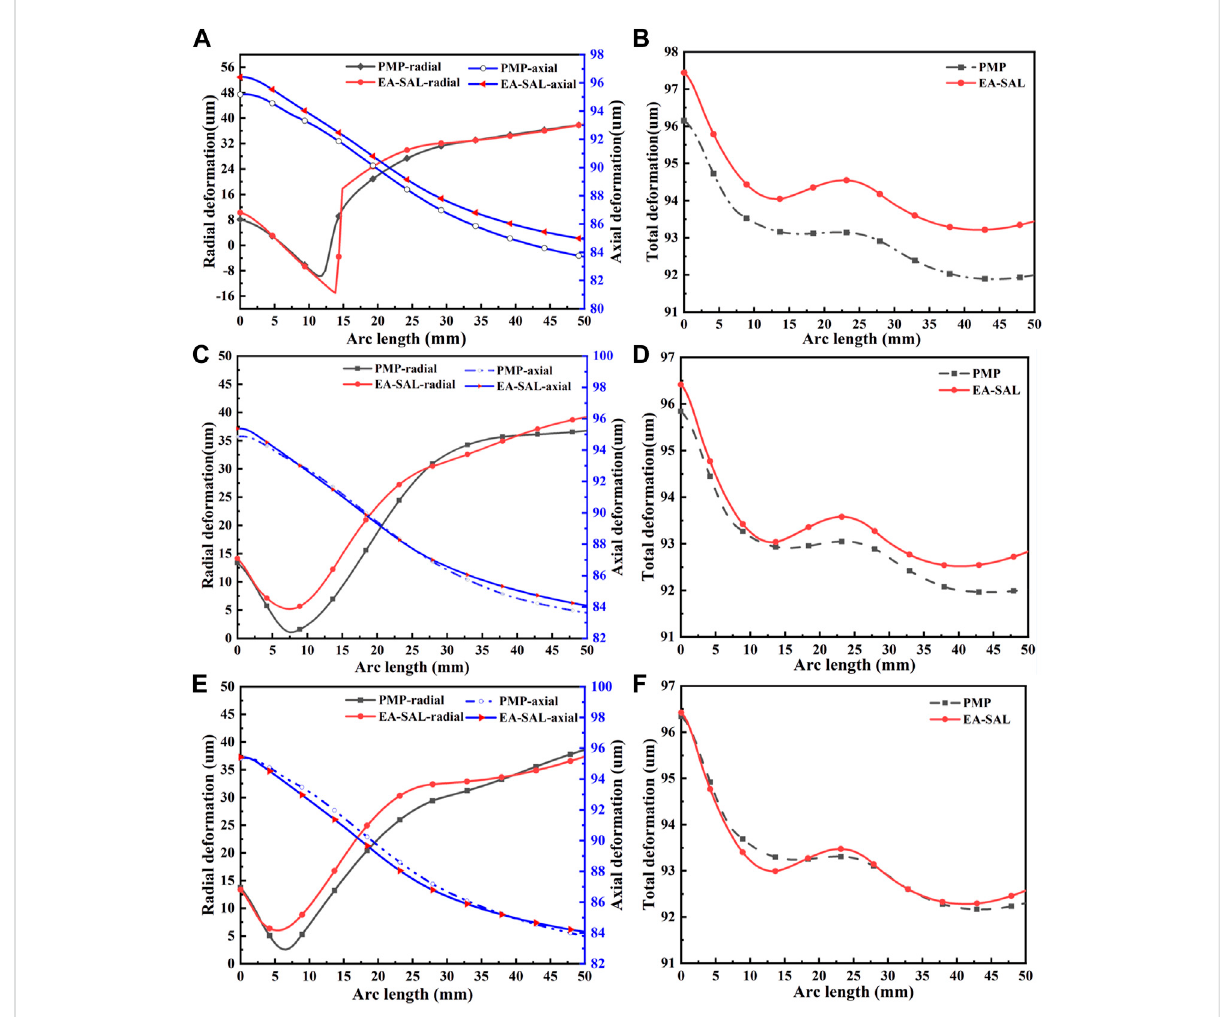
FIGURE 10 The top deformation curve under temperature load at different spindle positions [ (A,B) -60 ° ; (C,D) -180 ° ; (E,F) -240 °